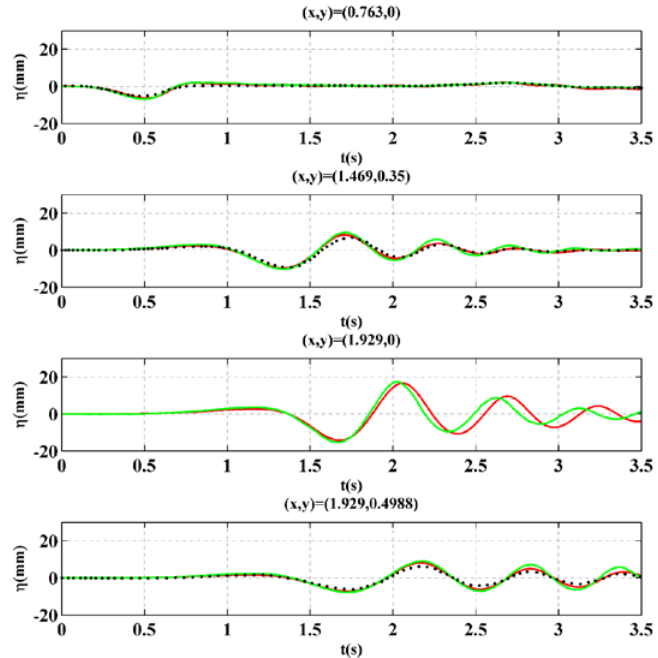
Figure 11. Comparison of present results (red line) with experimental data [6] (black dots) and the results in Fuhrman and Madsen [10] (green line) in case 2.